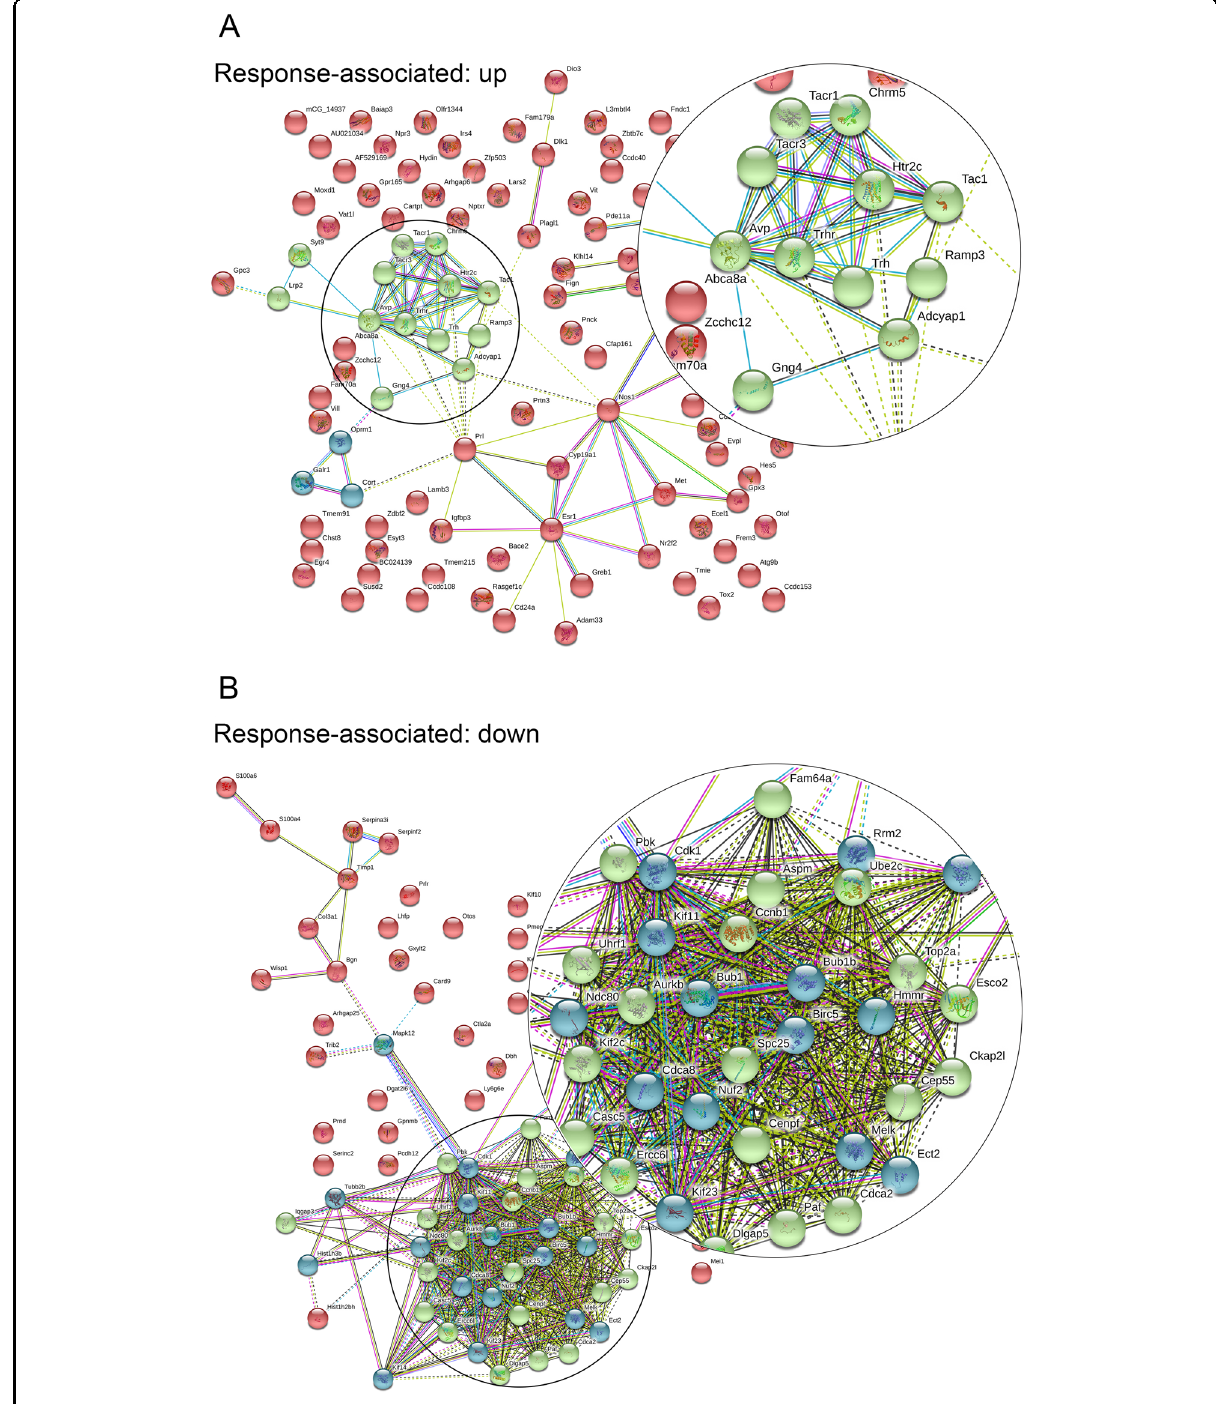
Fig. 3 Pathway analyses of response-associated transcripts. A Upregulated response clusters: in a good vs poor responder comparison of dentate gyrus transcriptomes, we plotted all 117 upregulated genes and performed a kmeans clustering cluster analysis. We could detect two response-associated clusters (blue and green), and we showed their respective protein – protein interaction (PPI) pro fi le (average local clustering coef fi cient: 0.304, PPI enrichment p value: <1.0e − 16, n = 19). B Downregulated response clusters : in a good vs poor responder comparison of dentate gyrus samples, we plotted all 94 downregulated genes and performed a kmeans clustering cluster analysis. We could detect two response- associated clusters (blue and green) and we revealed their respective protein – protein interaction (PPI) pro fi le (average local clustering coef fi cient: 0.528, PPI enrichment p value: <1.0e − 16, n = 19). Insets show higher magni fi cation of the most interesting clusters for improved